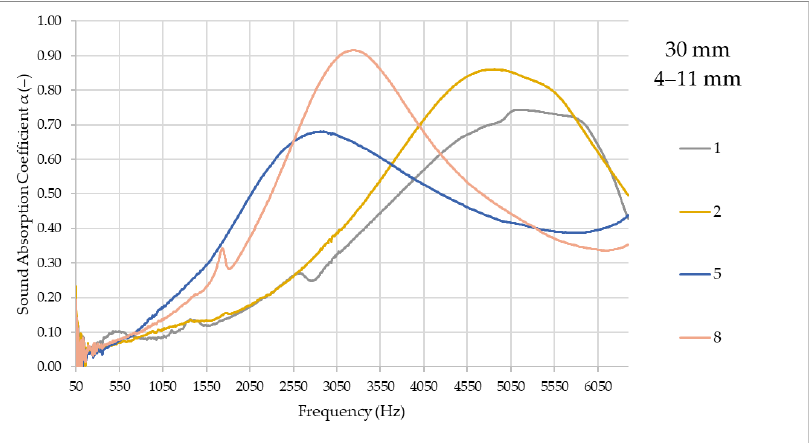
Figure 2. Sound absorption coefficient as a function of frequency of tested specimens of bark panels 1, 2, 5 and 8 with a thickness of 30 mm and a particle size of 4 to 11